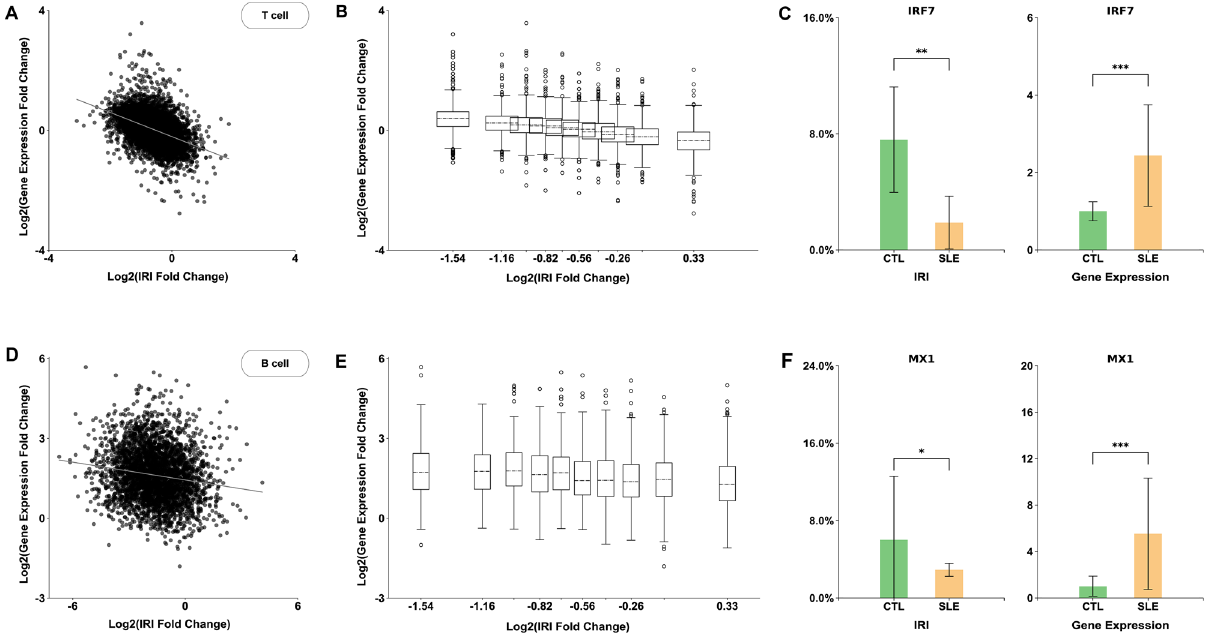
Figure 2. Gene expression level is associated with IR in T and B cells. ( A ) The scatter plot of fold change in gene expression vs. the fold change of IRI with a Pearson’s correlation coefficient of − 0.34 ( p < 5E − 200) for T cells. ( B ) The box plot of ( A ) where genes were evenly divided into 10 bins of equal numbers according to the sorted IRI fold changes. The fold changes in gene expression for each bin were shown as a box plot along the y-axis and the average fold change in IRI for each bin was labeled along the x-axis. ( C ) Fold change in IRI and gene expression for a specific gene IRF7 as an illustrative example. A decreased IRI level (left panel) occurred with an increased gene expression level (right panel) for IRF7 in SLE patients relative to the controls (CTL). ( D ) Same as ( A ) but for B cells with a Pearson’s correlation coefficient of − 0.062 ( p = 0.0019). ( E ) Same as ( B ) but for B cells. ( F ) Same as ( C ) but for B cells with a specific gene MX1 as an example showing the opposite fold changes in IRI and gene T-cell activation 23 . Using ChIP-Seq of RNA Pol II or histone mark H3K36me3 as a proxy for transcription activ-